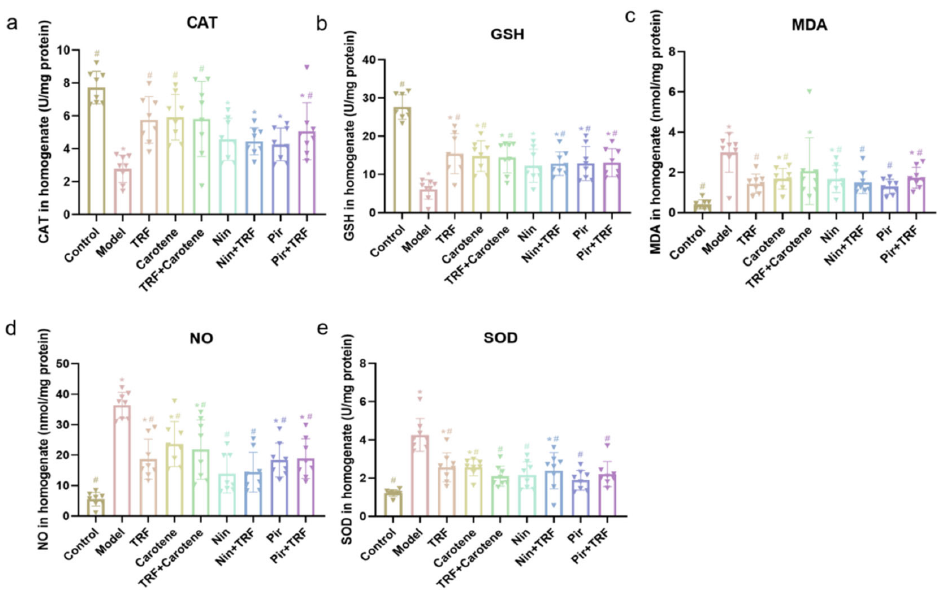
Figure 4. Effects on antioxidant enzymes and oxidative stress markers of TRF in the lung tissues of BLM-induced lung fibrosis ( a – e ); n = 8; Note: compared with CON group, * represents p < 0.05; Compared with MOD group, # represents p < 0.05;.